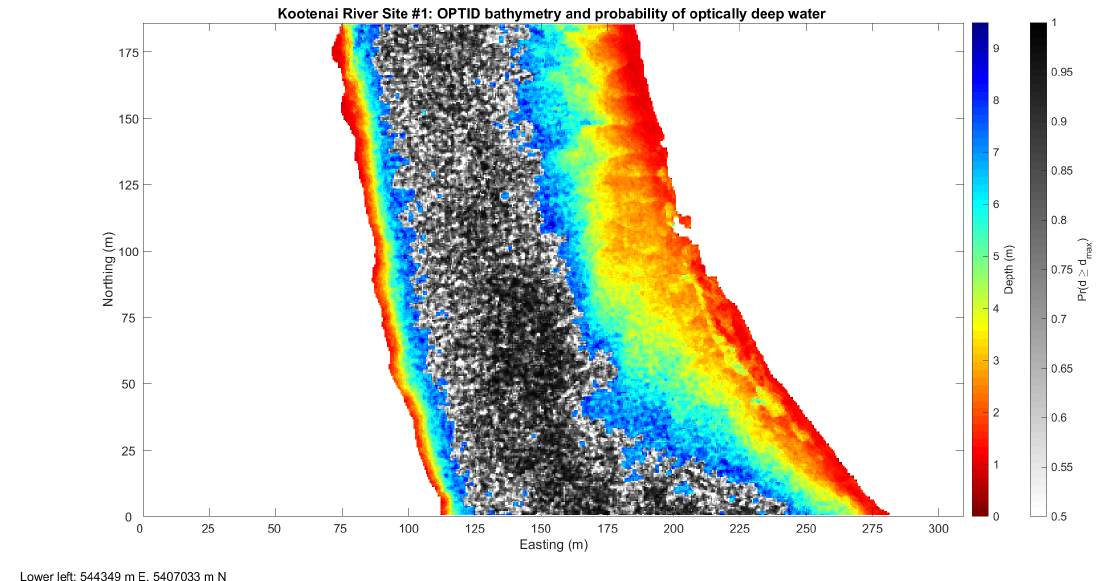
Figure 10. OPTID-derived bathymetry and Pr ( OD ) for areas inferred to be deeper than the d max of 9.5 m estimated via